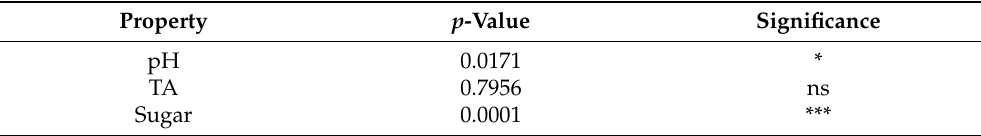
Table 4. Influence of foliar fertilization on pH, total acidity, and sugar must.